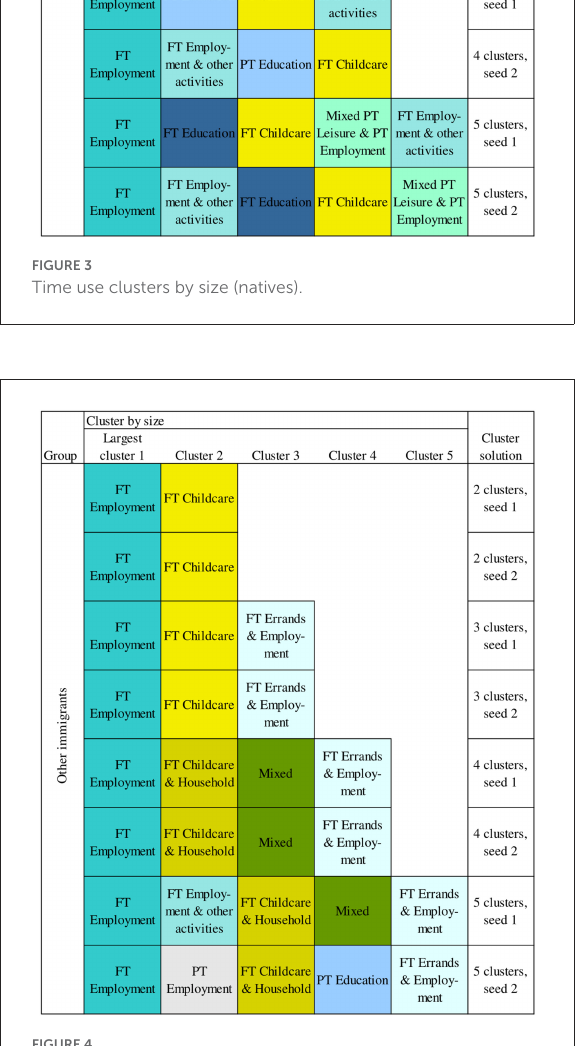
FIGURE4 Time use clusters by size (other